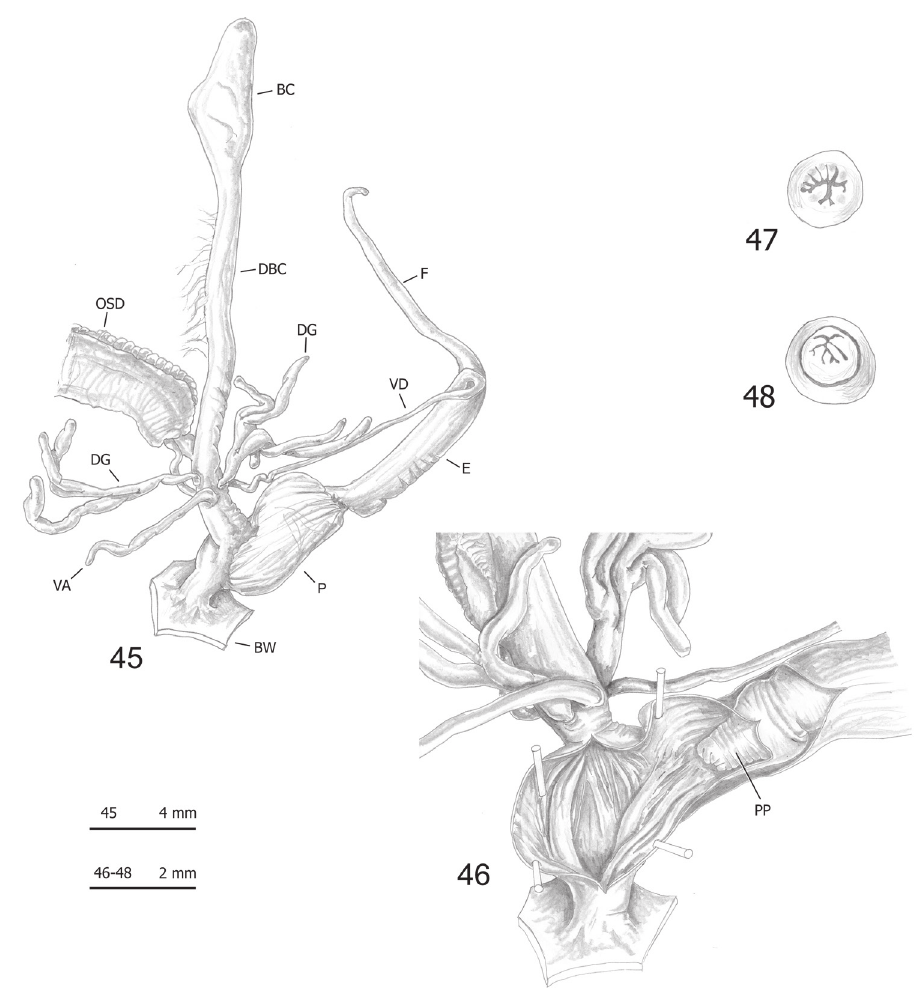
Figures 45–48. Genitalia (proximal parts excluded) ( 45 ), internal structure of distal genitalia ( 46 ), transverse sections of medial epiphallus ( 47 ) and apical penial papilla ( 48 ) of Monacha pantanellii from Vallonina [Val] (FGC